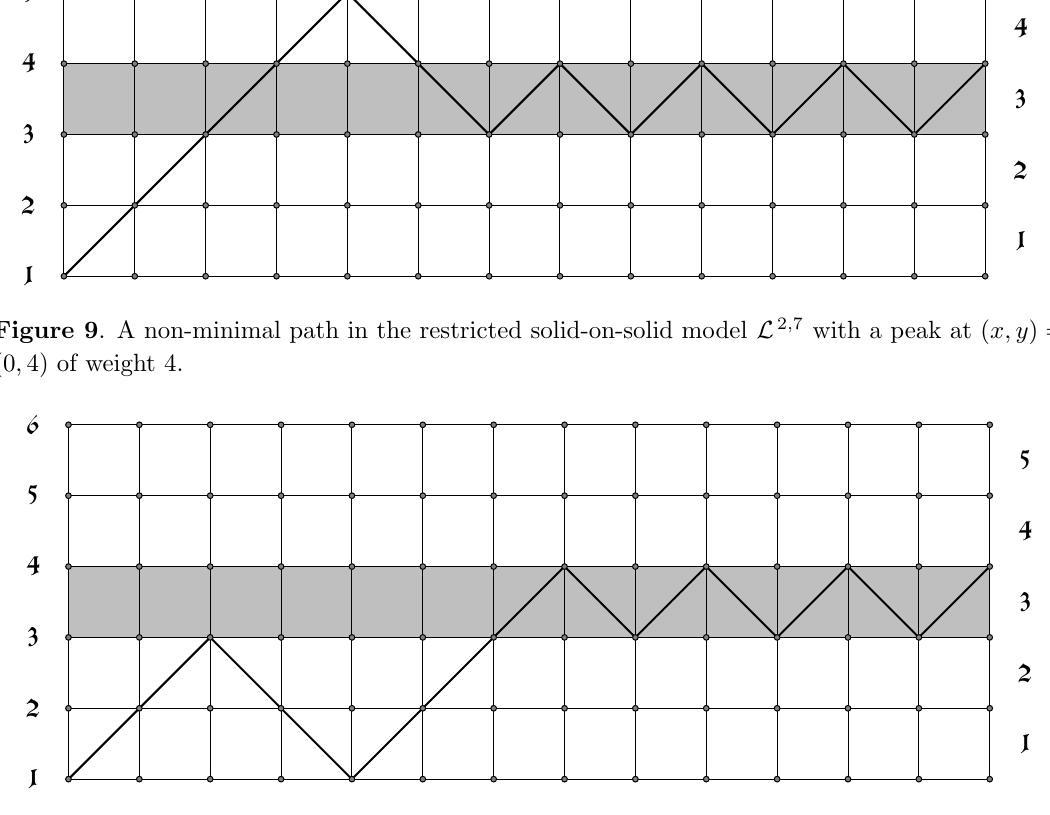
Figure 10 . A non-minimal path in the restricted solid-on-solid model L 2 ; 7 , with a valley at ( x; y ) = (2 ; 2) of weight 4. The valley between the 3-rd vertical line (at i = 2) and the 7-th vertical line (at i = 6) is obtained by re(cid:13)ecting with respect to the lower boundary of the ground-state band from the peak in (cid:12)gure